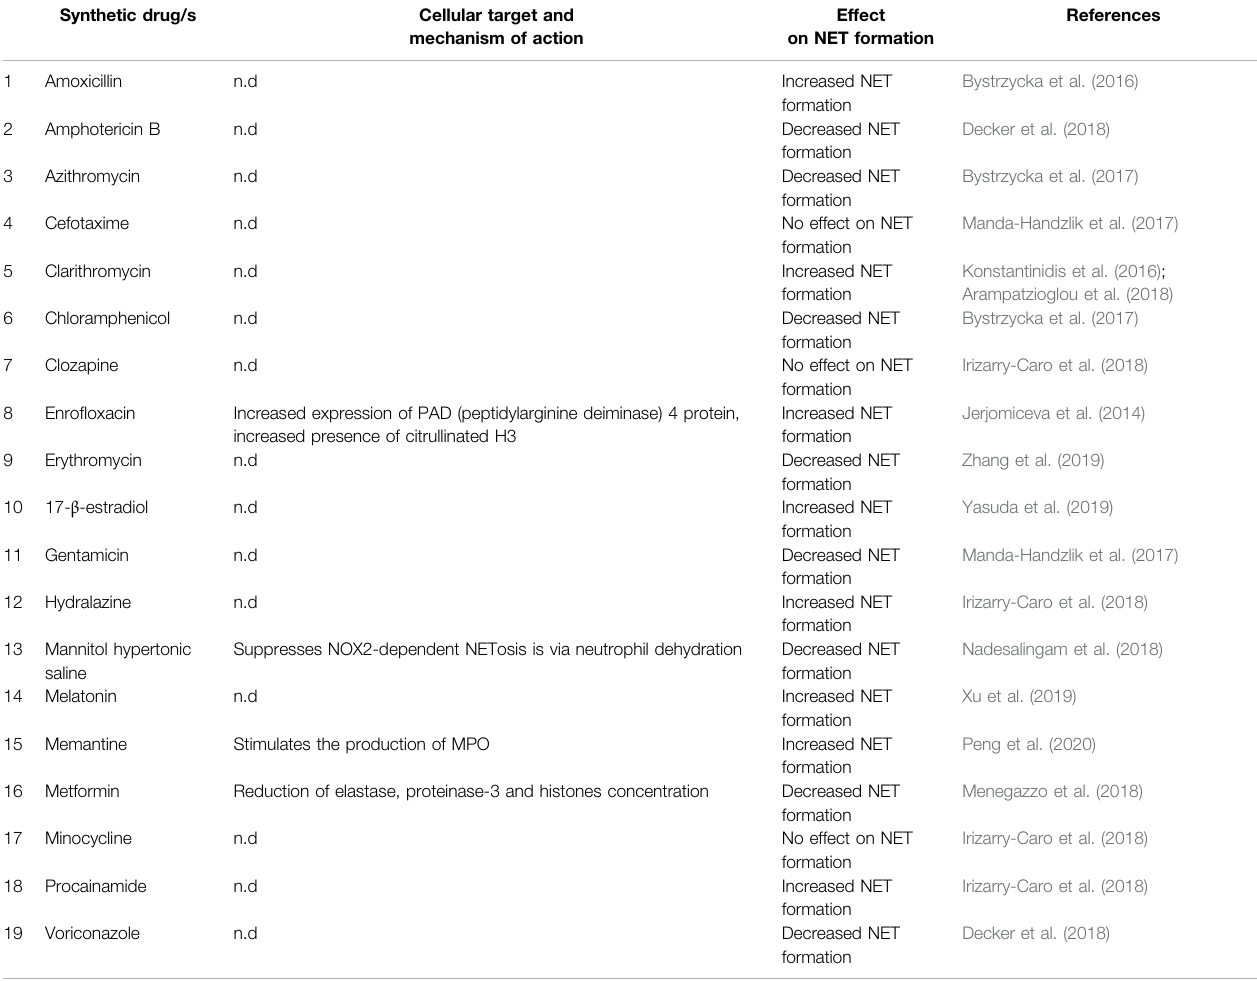
TABLE 9 | List of selected synthetic drugs with documented impact on NET formation. Synthetic